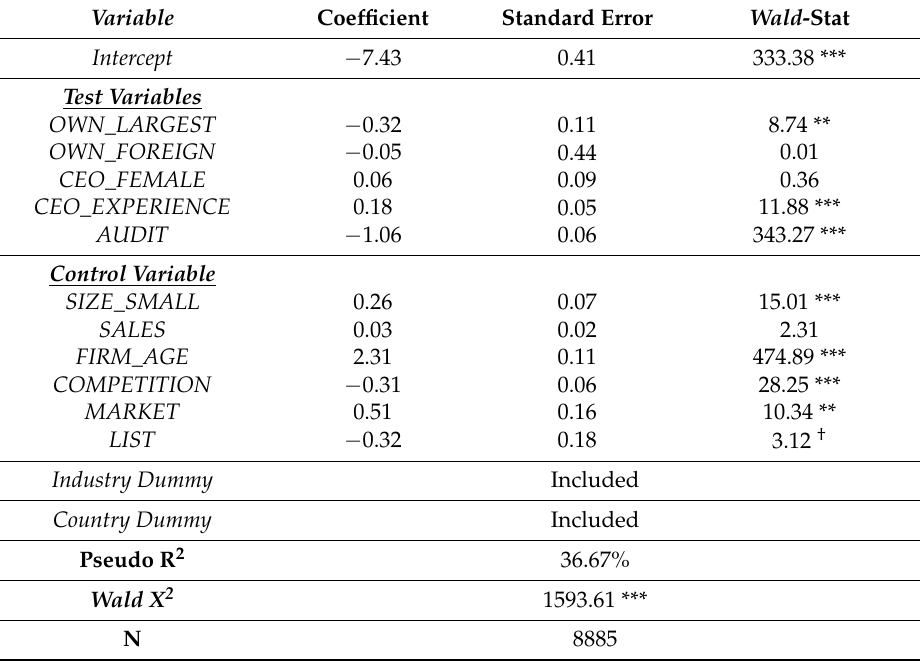
Table 6. Regression Results (Total Observations =